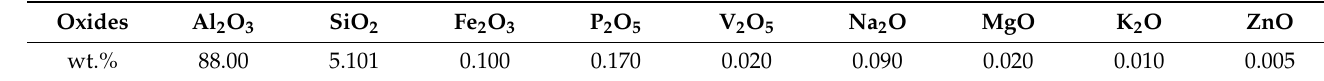
Table 1. Chemical composition of γ ANPs.